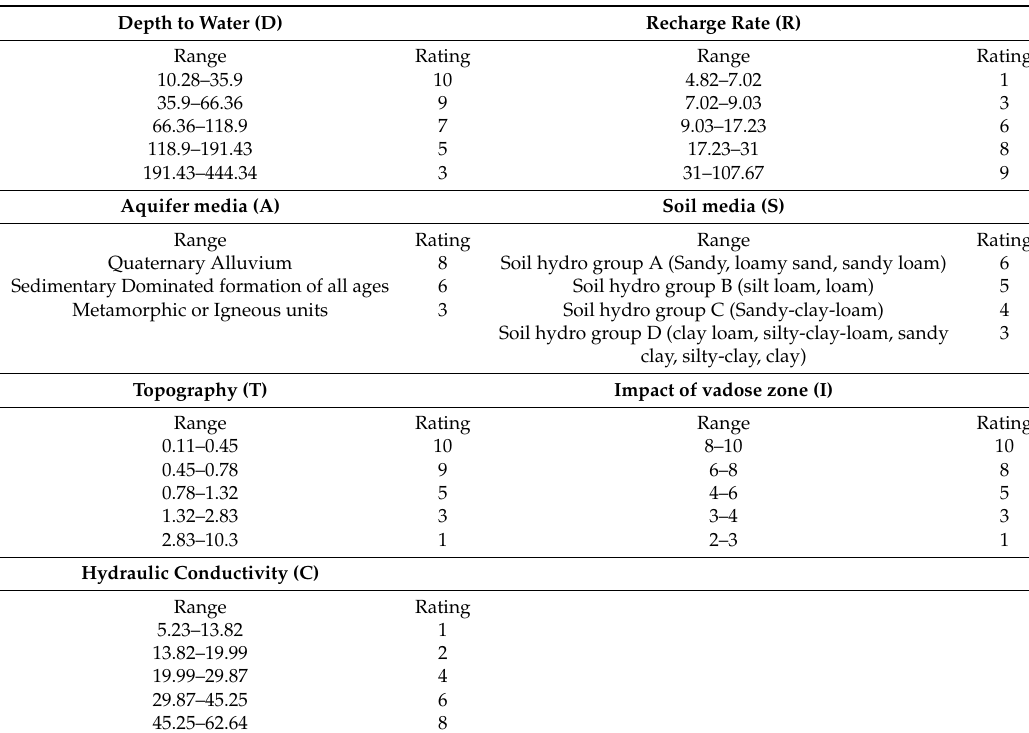
Table 2. Ratings and weights given to DRASTIC